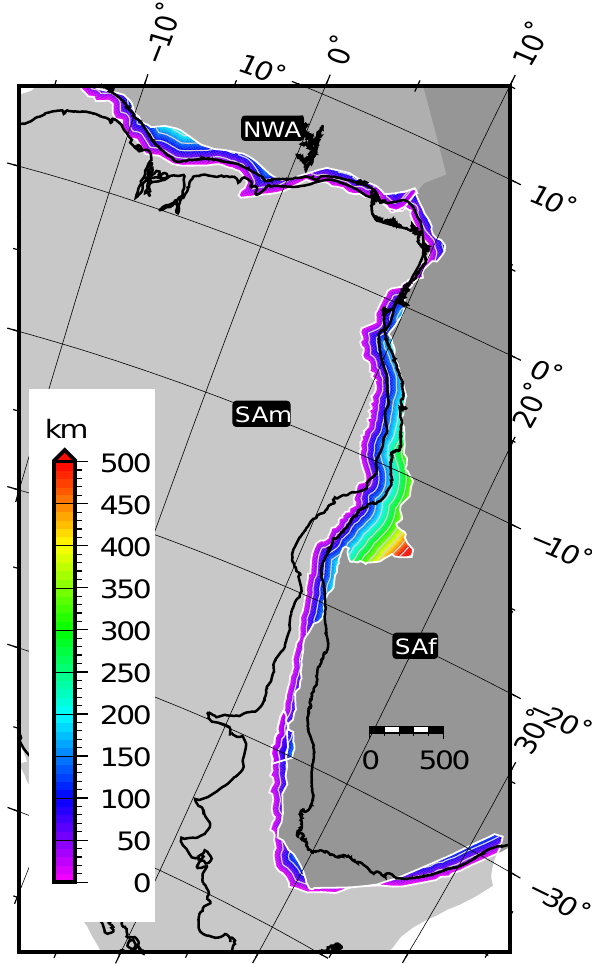
Fig. 14. Overlap between the conjugate present-day landward lim- its of the oceanic crust (LaLOC) for South America (SAm), south- ern Africa (SAf) and northwest Africa (NWA). Shown is the fit re- construction at 143 with SAf fixed in present-day position. Spac- ing between contour lines is 50km, present-day coastlines as thick black lines. Note that the position of the LaLOC along the vol- canic margins in southern part of the South Atlantic rift is not well constrained. Largest overlap is created between the Campos/Santos Basin margin and the southern Kwanza/Benguela margin, implying up to 500km extension for the SE’most Santos Basin.